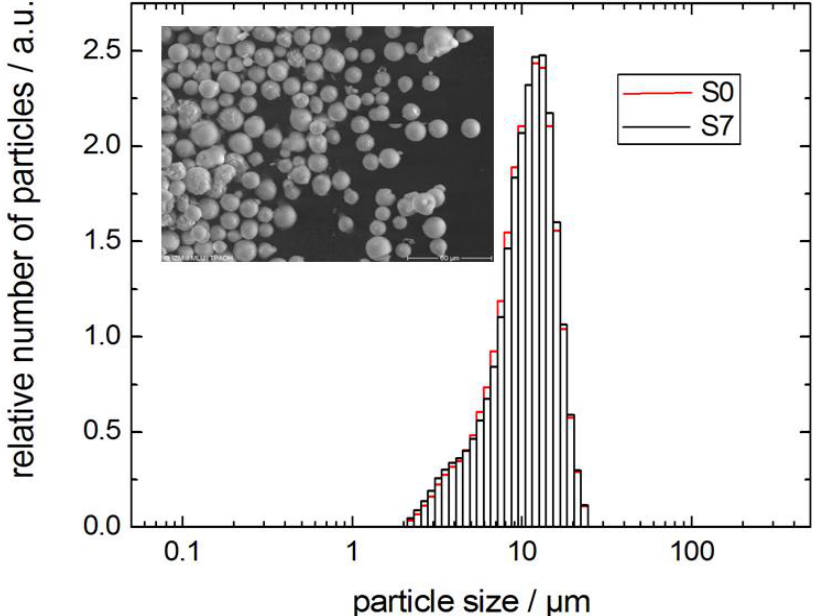
Figure 5. Particle size distribution of LiChrospher ® Si 60 (sample S0) and MCM-41 (sample S7) from pseudomorphic transformation and SEM image